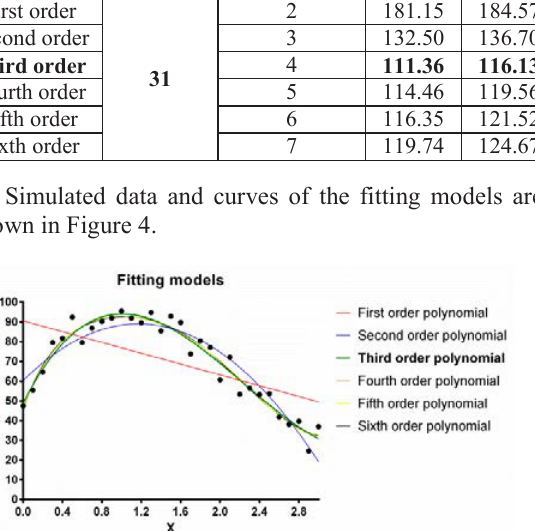
Fig. 5. Simulated data (101 points) and curves of the fitting models (six fitted polynomials curves of increasing order, from 1 (straight line) to 6).